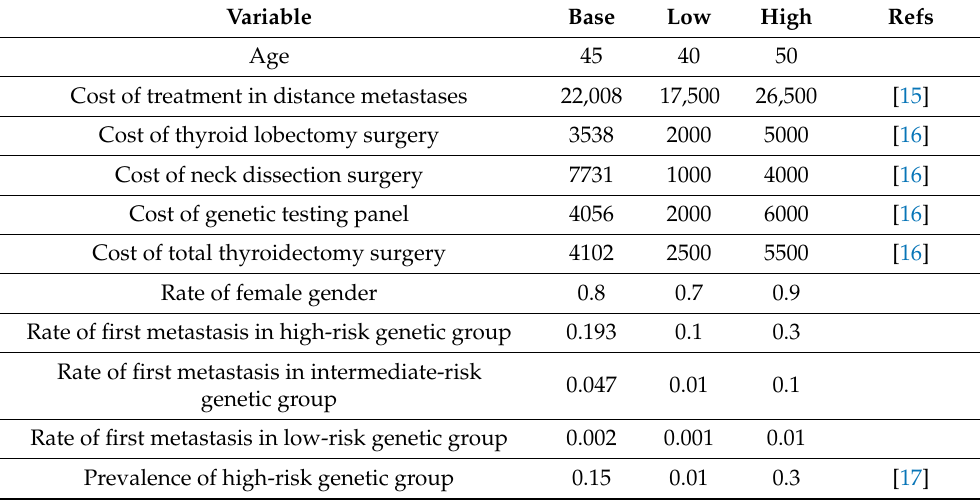
Figure 1. The model decision tree. The model comparing the results of two optional management strategies for low-risk differentiated thyroid cancer: without vs. with the performance of genetic testing. The variable definitions are detailed in Table 1. PTC: papillary thyroid carcinoma; HT: hemithyroidectmy; TT: total thyroidectomy; Clon 1: represents the same decision tree branches as shown following the number 1. Table 1. The model’s probabilities and costs